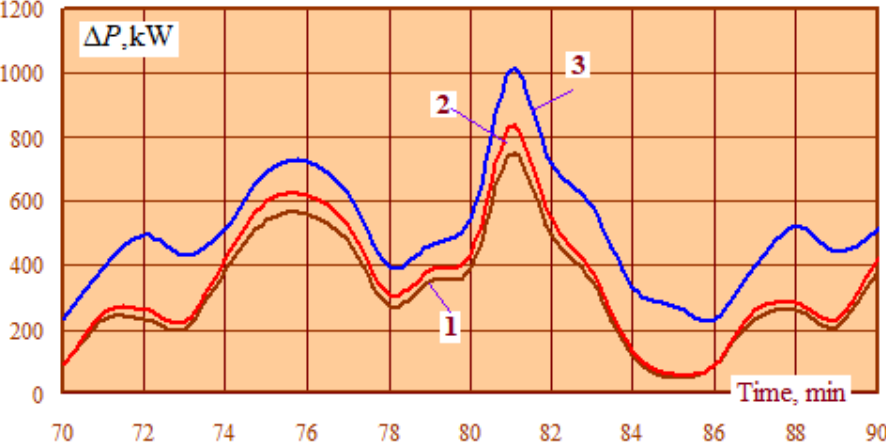
Figure 8. Power losses in the traction network of the middle inter - substation area—callout numbers correspond to those in Figure 6.